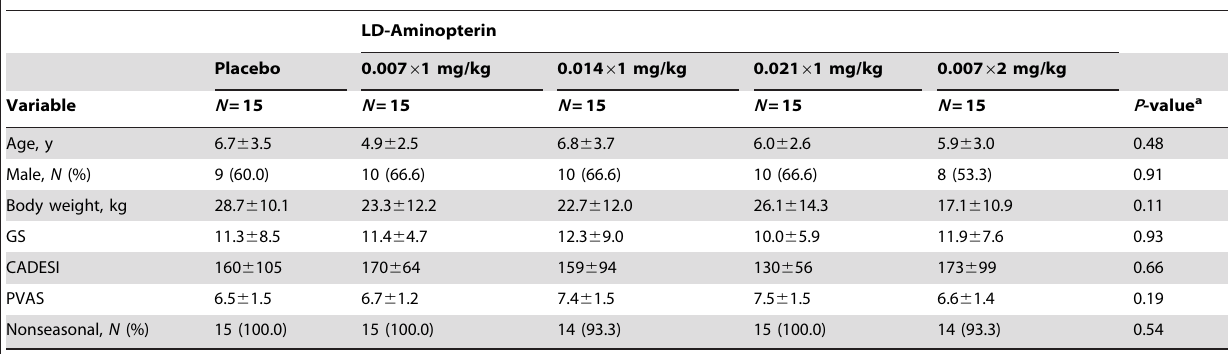
Table 1. Subject demographics and baseline AD characteristics.